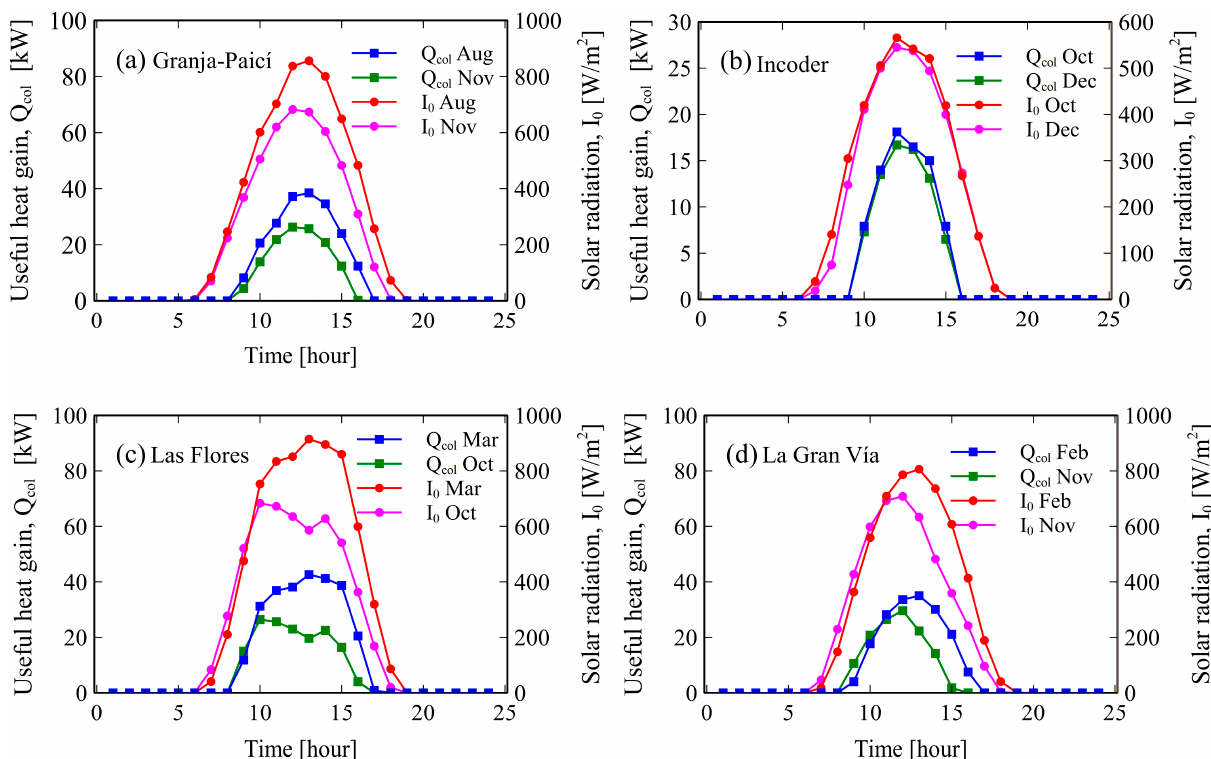
Figure 6. Variation of solar collector heat gain as a function of total solar radiation.